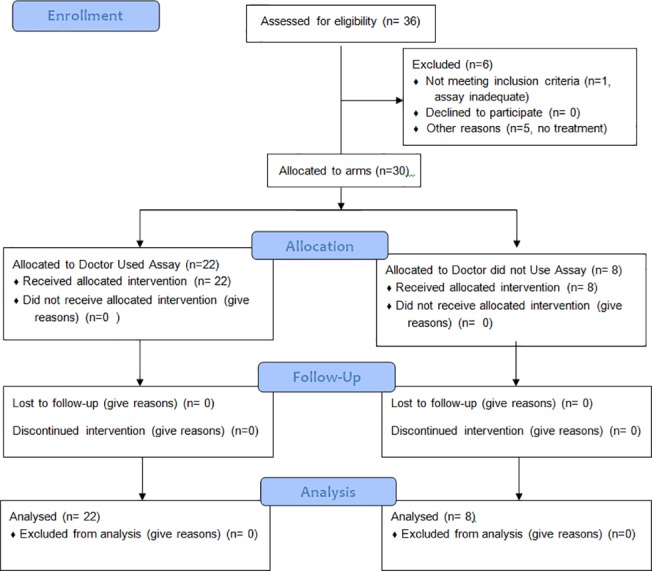
CONSORT Flow Diagram.